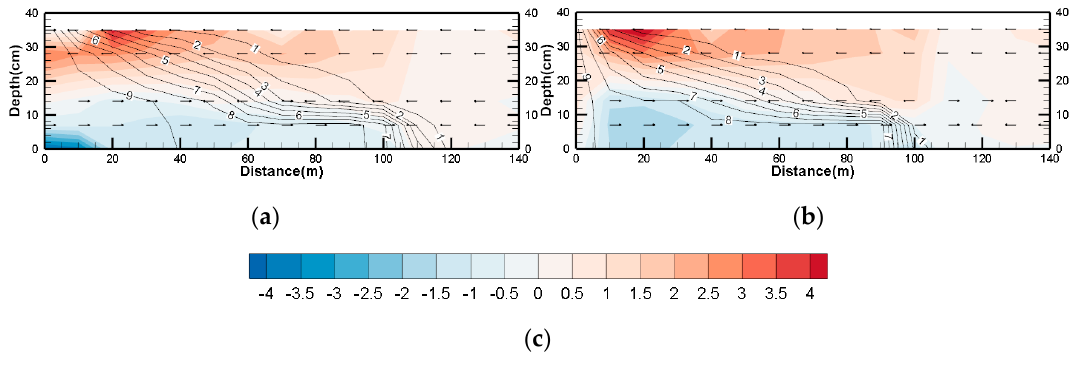
Figure 9. Residual circulation profiles. ( a ) Case 1; ( b ) Case 2; ( c ) Legend of velocity (unit: cm/s). The arrow represents the flow direction. The contour represents the isohaline.